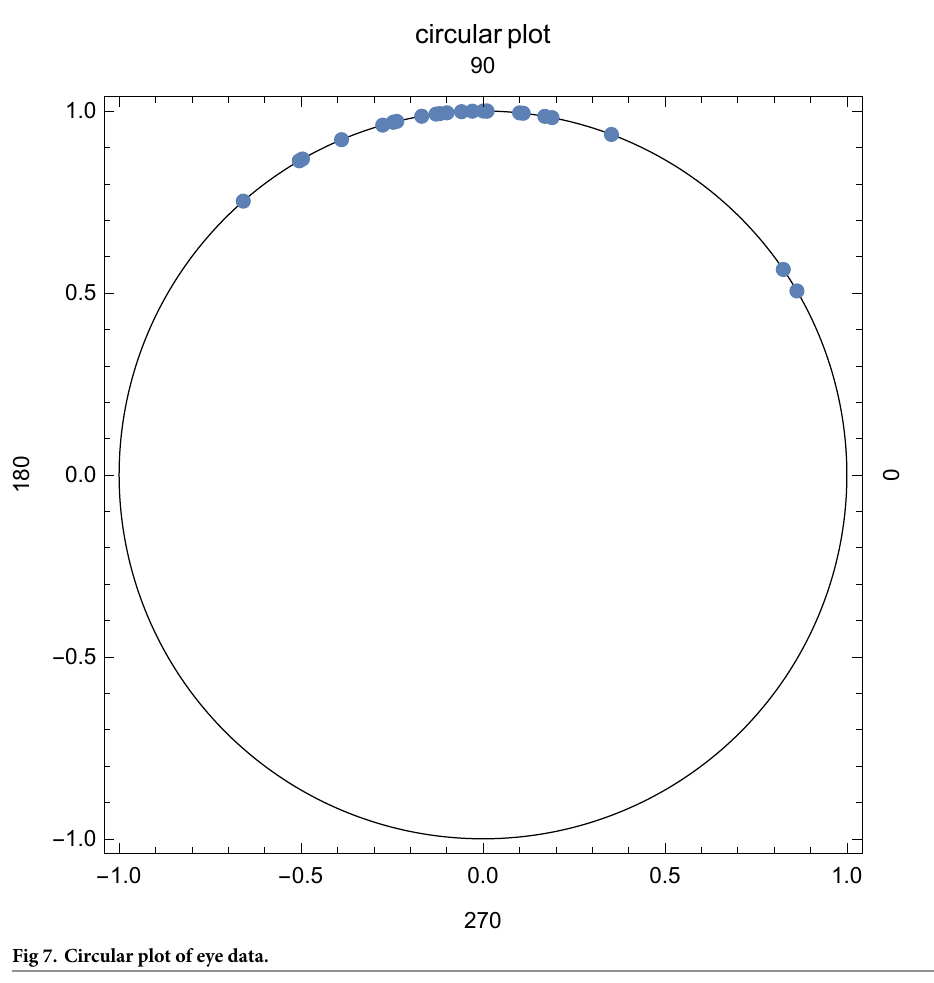
Fig 7. Circular plot of eye data.